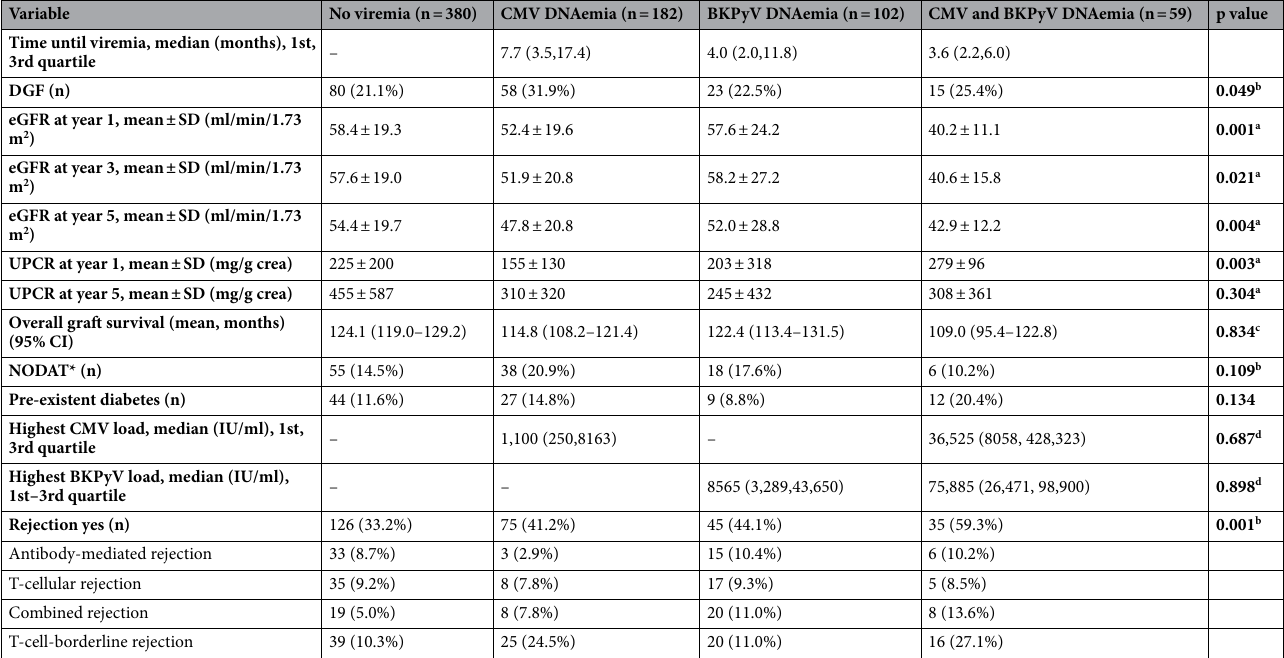
Table 2. Patients’ clinical outcome parameters. DGF delayed graft function, eGFR estimated glomerular filtration rate, UPCR urine protein/creatinine ratio, NODAT new onset diabetes after transplantation. Bold: main variables and p-values. a Kruskal–Wallis test. b Fisher’s exact test. c Log rank test. d Mann–Whitney U